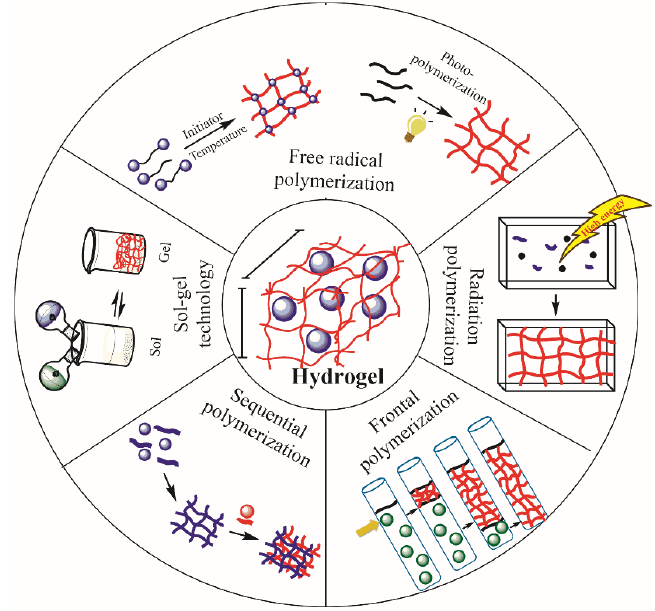
Figure 3. Synthesis of hydrogels by different techniques. Table 1. PNVCL hydrogels obtained by different